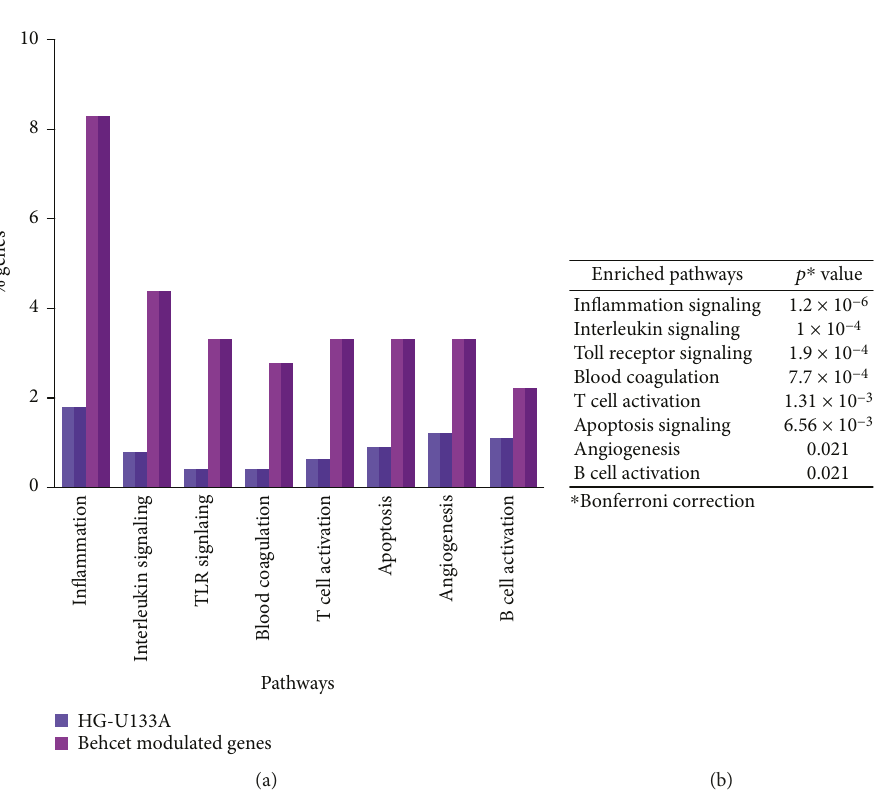
Figure 2: Pathways enrichment of BD modulated genes. (a) Graphical representation of genes ascribed to the enriched pathways, expressed in y -axis as percentage of all genes represented on the A ff ymetrix Human gene chip U133A 2.0 (dark purple bars) or as the percentage of genes in the dataset of Behcet ’ s modulated genes (light purple bars); x -axis: enriched pathways. (b) p values associated with the signi fi cantly enriched pathways. Pathways with p values < 0.05 versus the distribution of all genes on the microarray chip, after a Bonferroni correction, were considered as signi fi cantly enriched.